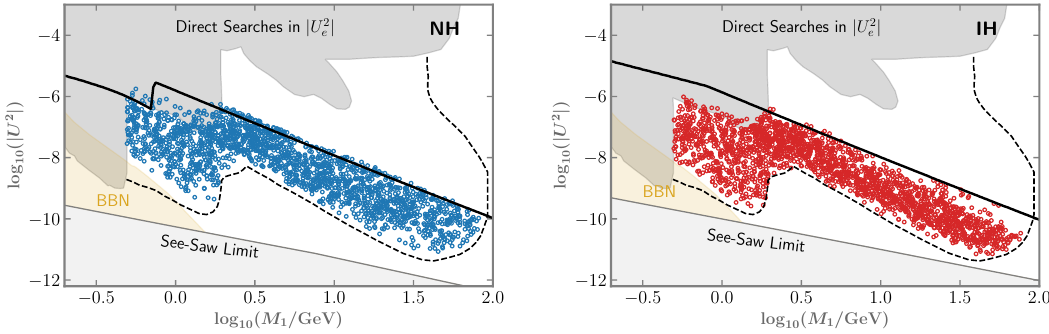
Figure 12 . Numerical result of the Bayesian analysis (blue (red) points for NH (IH)) together with the analytical derived upper bound on the HNL mixing (black line). The grey shaded regions is excluded by direct searches or neutrino masses (seesaw limit), while the yellow one is excluded by big bang nucleosynthesis